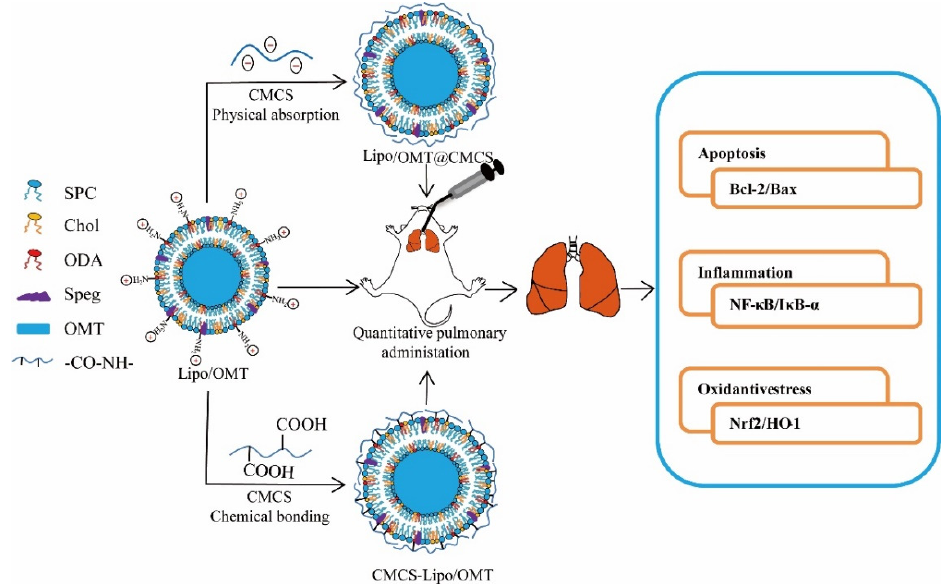
Scheme 1. Schematic illustration for the preparation of OMT liposomal preparations and therapeu- tic effects on emphysema in mice.